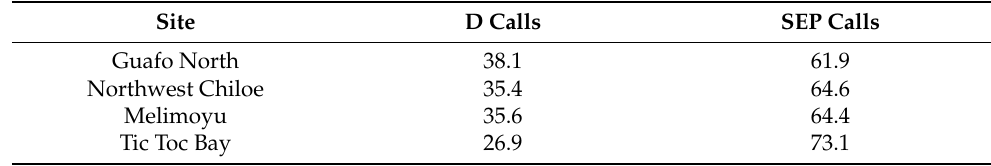
Table 4. Percentages of call types at each recording site.